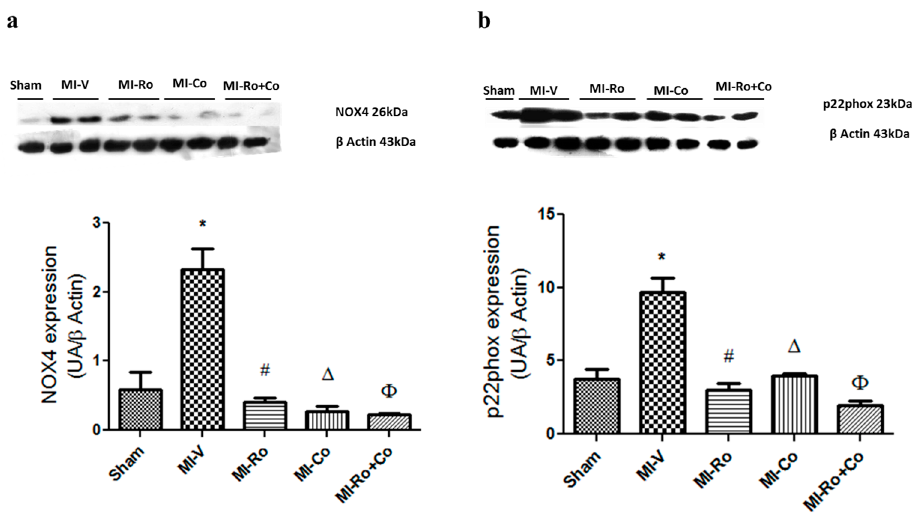
Figure 5. The effect of extracts from Rosmarinus officinalis ( Ro ), Crataegus oxyacantha ( Co ), and their combination ( Ro+Co ) on NADPH oxidase (NOX4) ( a ) and p22phox ( b ) protein expression in ischemic area of the left ventricles from sham, myocardial infarction (MI)-vehicle treated, MI- Ro , MI- Co , and MI- Ro+Co experimental groups. The values show the mean ± SEM of six different experiments. p < 0.05 ANOVA one way post Tukey, * Sham vs. MI-V, # MI-V vs. MI- Ro , Δ MI-V vs. MI- Co , Φ MI-V vs. MI- Ro+Co .